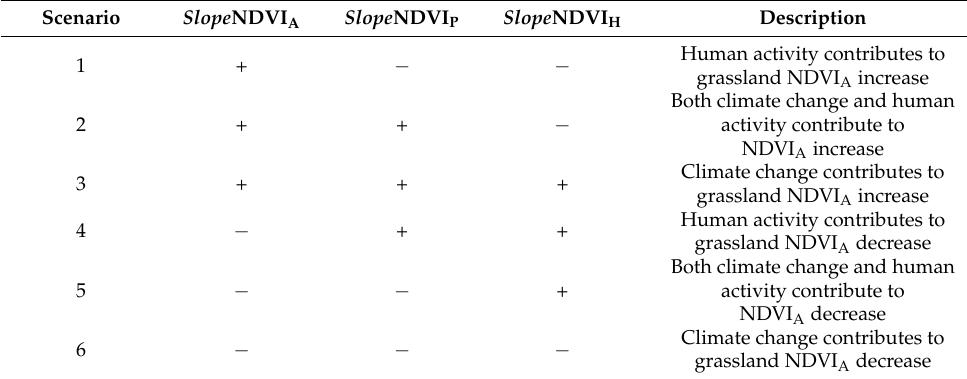
Table 1. Evaluation methods of climate change and human activities on grassland dynamics under six possible scenarios.